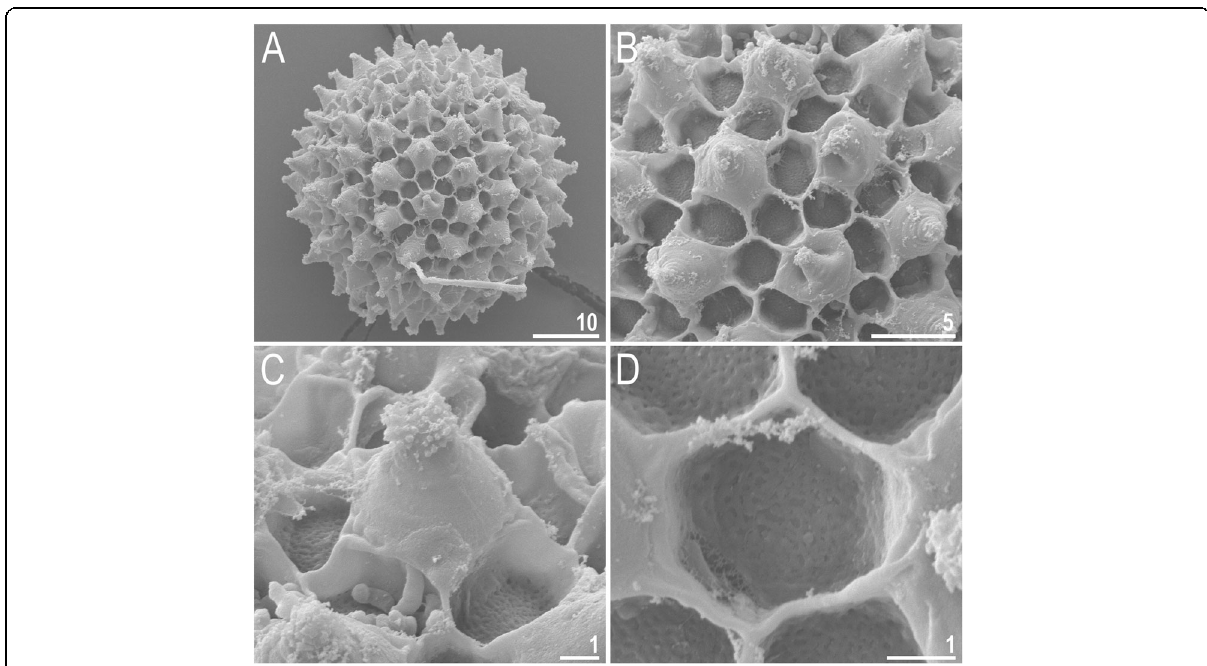
Fig. 39 Macrobiotus aff. polyopus species from Papua New Guinea – eggs seen with SEM: a – entire egg; b – d – details of the egg surface between the processes, areolation and egg processes. Scale bars in μ